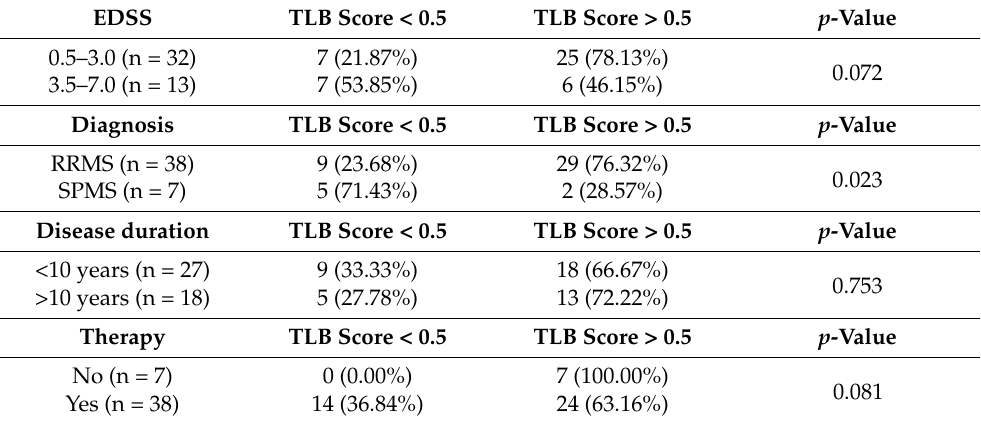
Table 4. Contingency table for clinical history information (EDSS, diagnosis stage, disease duration and treatment) in MS